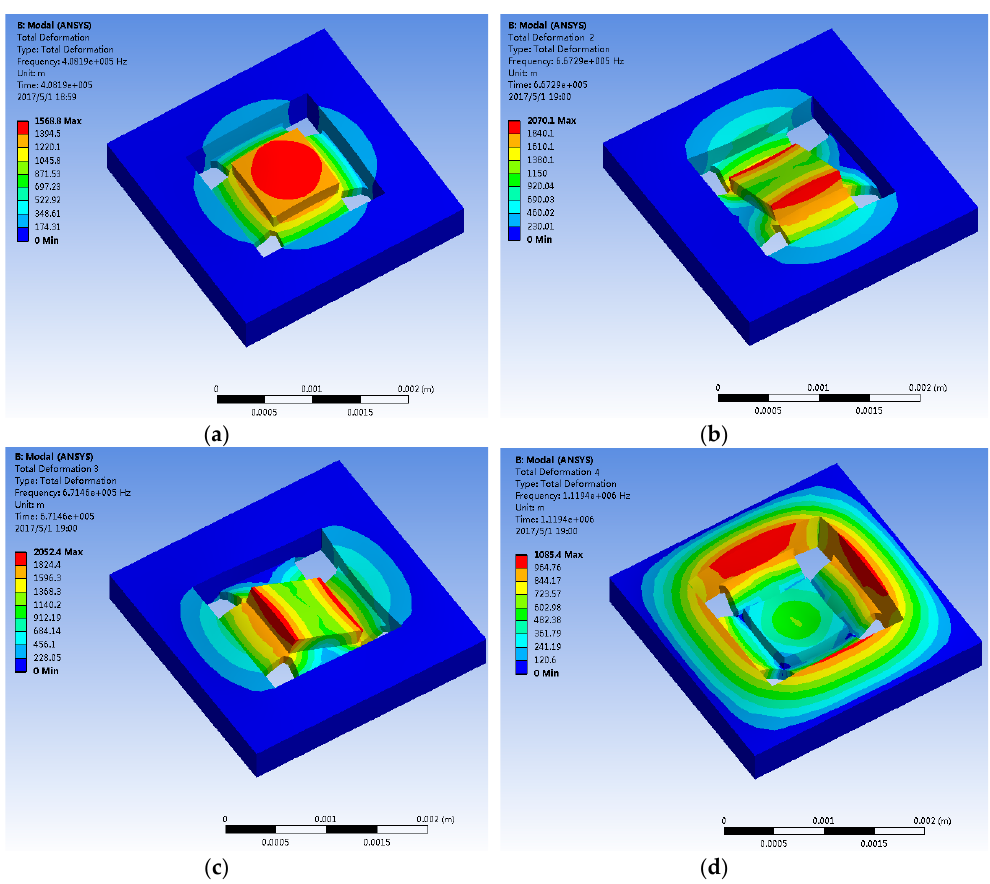
Figure 2. Mode simulation of HGMA structure: ( a ) ( b ) ( c ) and ( d ) are 1st, 2nd, 3rd and 4th order modes. Table 2. Resonant frequencies of the four modes.